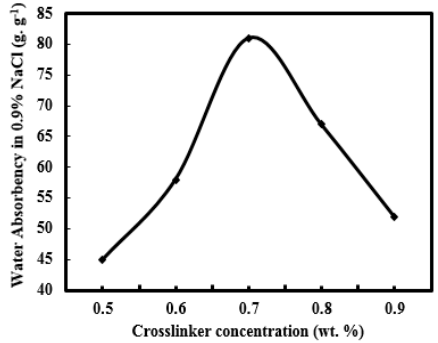
Figure 4. Effect of crosslinker N, N-methylenebisacrylamide (MBA) concentration on water absorbency of PAA-AM/FA in 0.9% NaCl aqueous solution (polymerization temperature, 70 °C; mass ratio of AA/AM, 1.5; neutralization degree of AA, 70%; FA concentration, 50%).